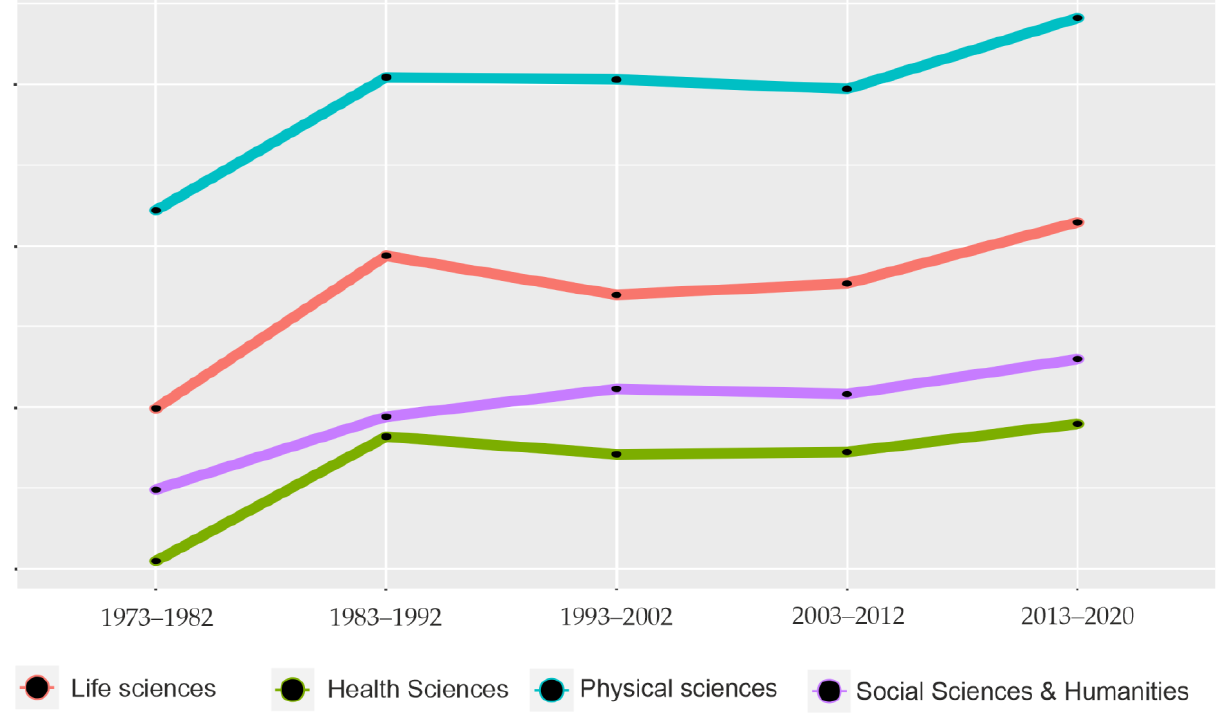
Figure 5. Aggregated Jaccard similarities per “Subject Area” over time. Dots denote the aggregated Jaccard similarity per time span and colors denote the affiliation to distinct “Clusters”.